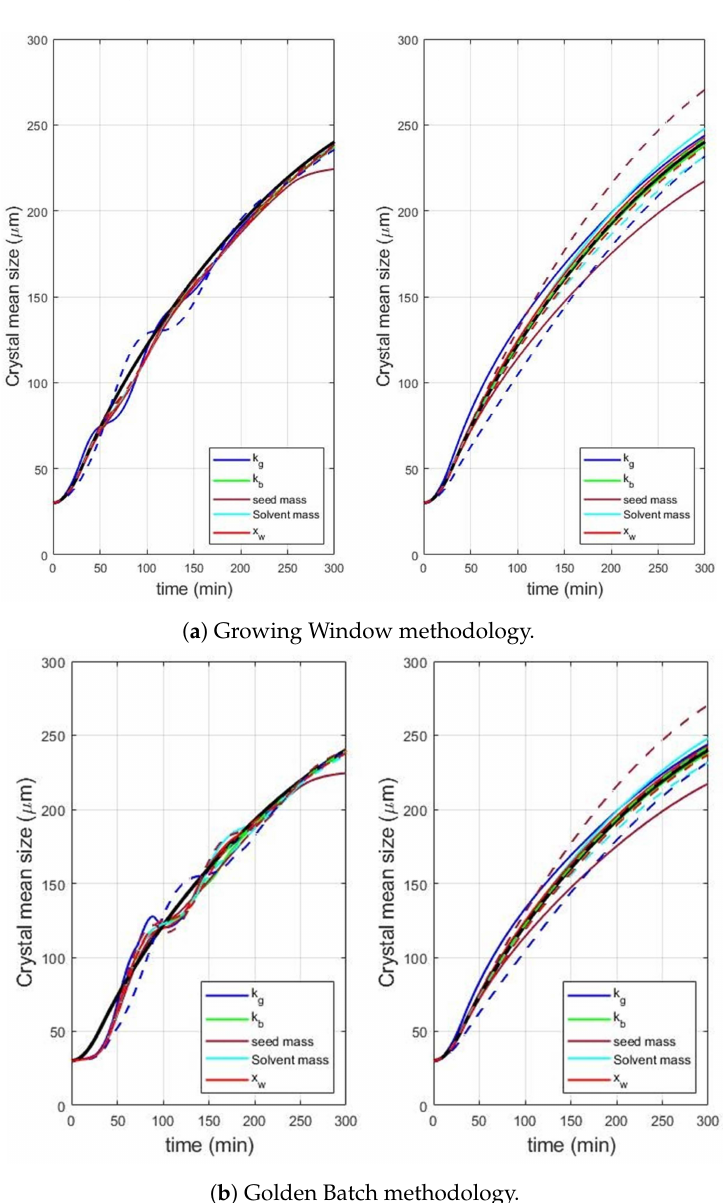
Figure 6. Controlled mean crystal size ( left ) and open-loop mean crystal size ( right ) obtained for the application of the different methodologies to the RBF predictive soft sensor with single step disturbances (positive disturbance: full line; negative disturbance: dashed